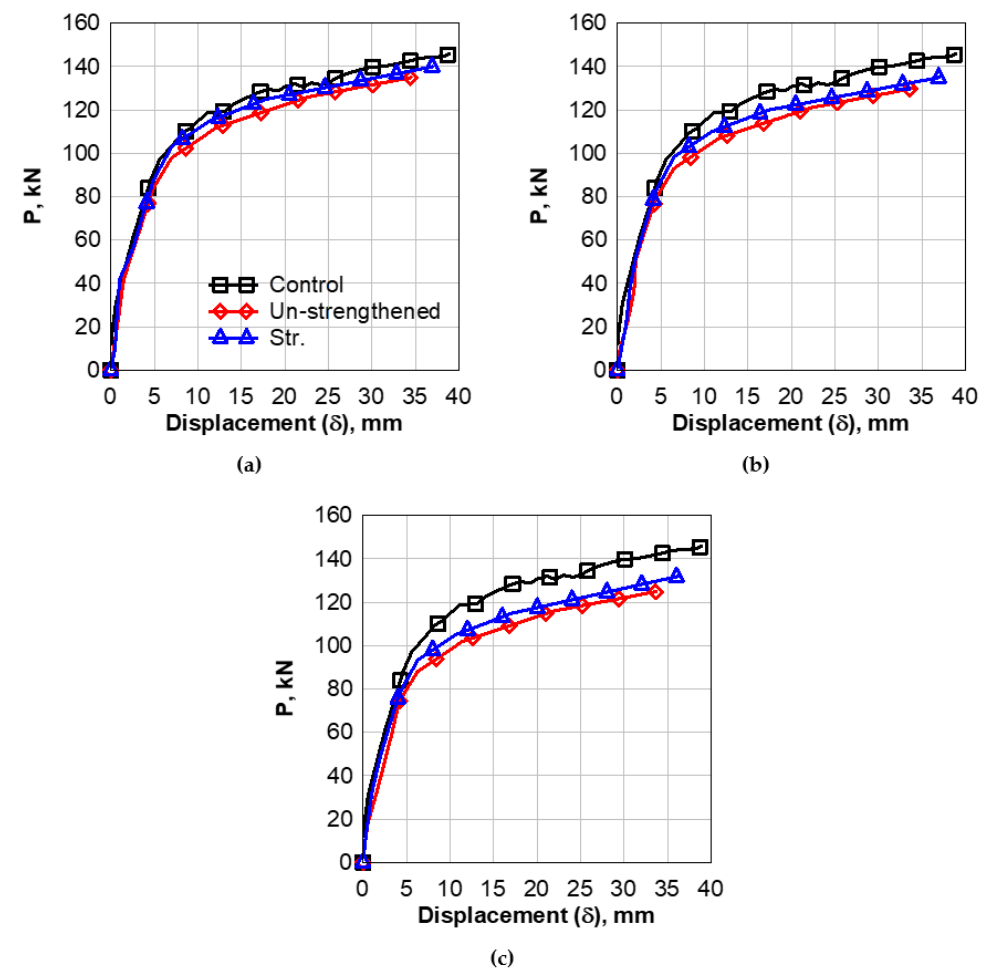
Figure 4. Load versus Mid-Span Deflection of Beams with Tension-Zone Opening. ( a ) opening 360 × 90 mm 2 ; ( b ) opening 360 × 150 mm 2 ; ( c ) opening 360 × 210 mm 2 .